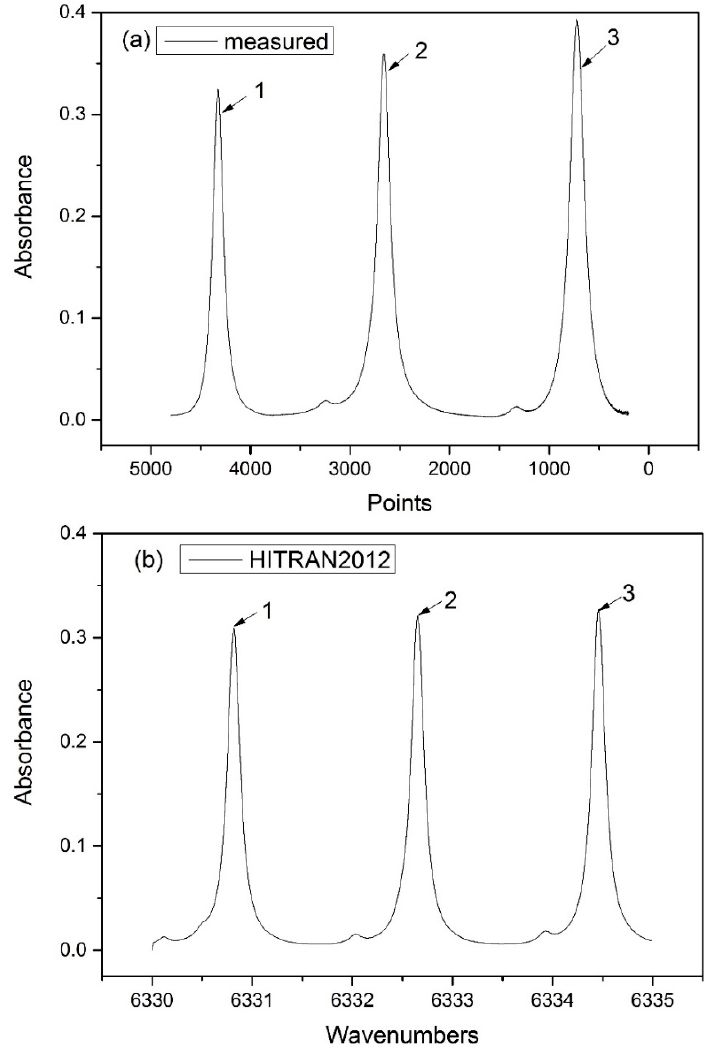
Figure 3. ( a ) Measured and ( b ) simulated absorbance of CO 2 at 296 K and 1 atm.